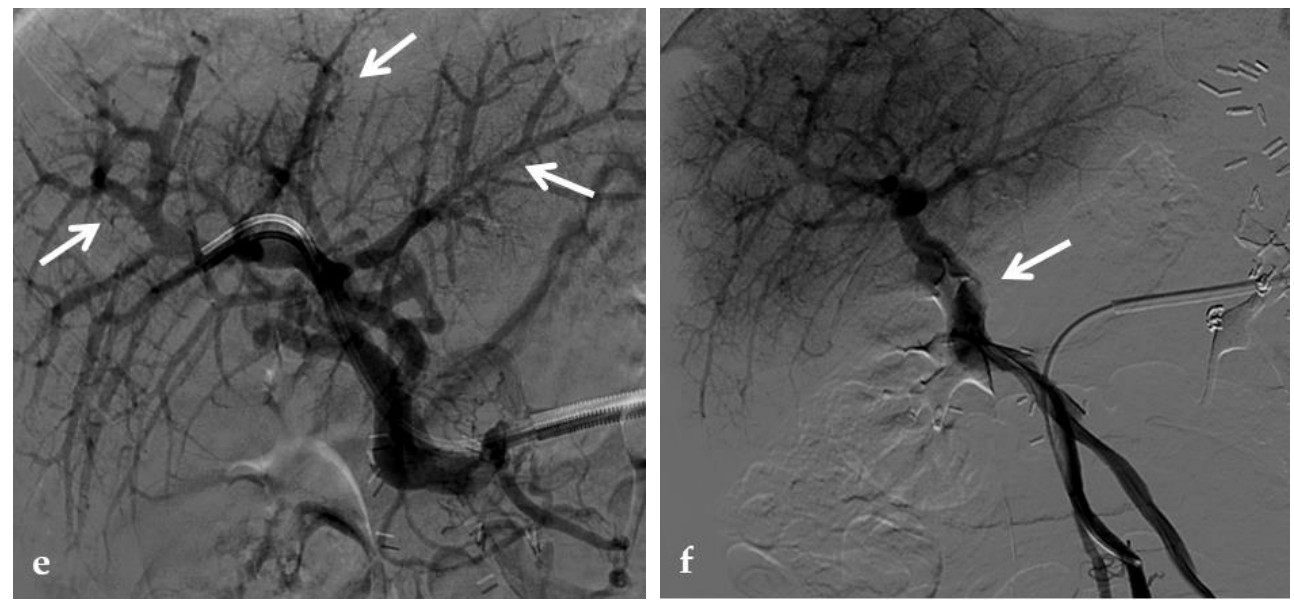
Figure 14. Anteroposterior view of a percutaneous transsplenic portography imaging series of an occluded Meso-Rex bypass in the same patient of Figure 8. ( a ) Percutaneous transsplenic portography shows extensive jejunal and gastric varices (arrows), with no opacification of the Meso-Rex bypass. ( b ) After superior mesenteric vein catheterization, portography shows the portal cavernoma (arrow) with no opacification of the native intrahepatic portal branches (whose patency was documented with retrograde portography in Figure 8). ( c ) Portography image shows successful recanalization of the mesenteric anastomosis of the Meso-Rex bypass (white arrow), with intrahepatic portal branches opacification (black arrows). ( d ) X-Ray image shows angioplasty of the bypass performed through a 9-mm non-compliant balloon catheter. During angioplasty, a focal notch (arrow) representing the mesenteric anastomotic stenosis is clearly visible. ( e ) Portography image acquired after bypass recanalization and angioplasty shows regular opacification of the intrahepatic portal system (arrows). ( f ) Portography image from the superior mesenteric vein shows a re-expanded Meso-Rex bypass with complete opacification in the mesenteric anastomotic tract (arrow). The intrahepatic portal system is regularly represented; the portal cavernoma and gastro-jejunal varices disappeared.